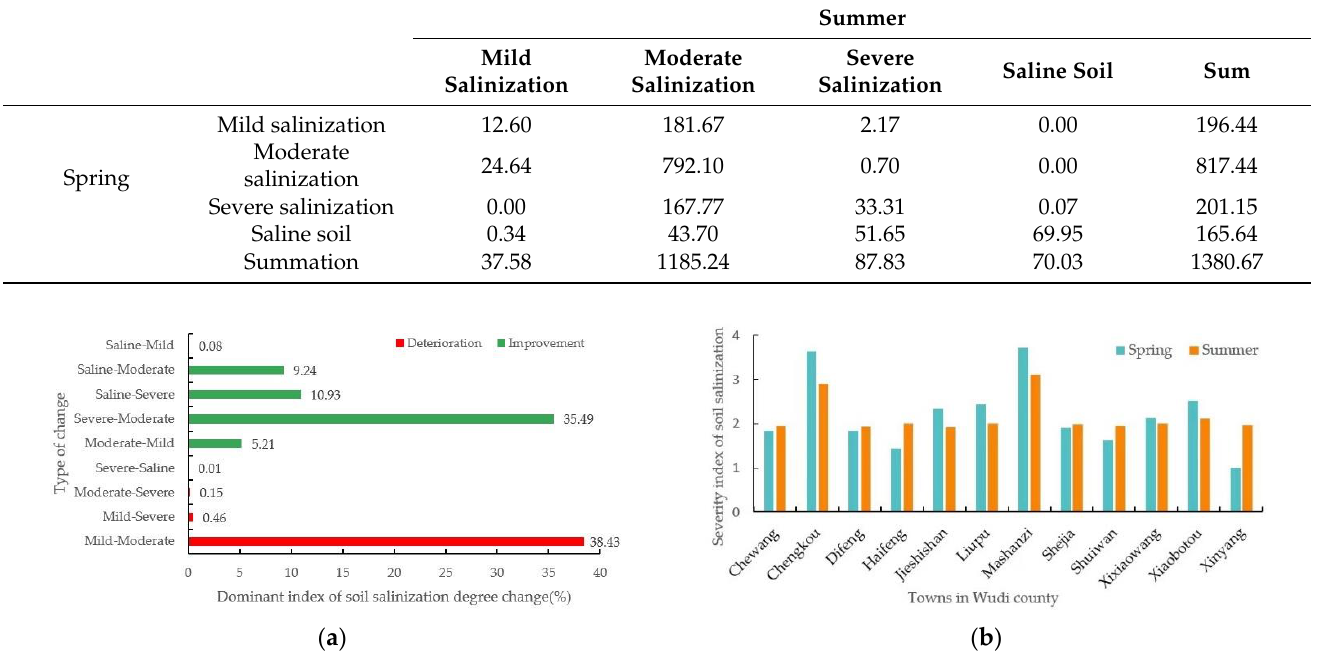
Table 6. Transfer matrix of salinization soil of different degrees from spring to summer.